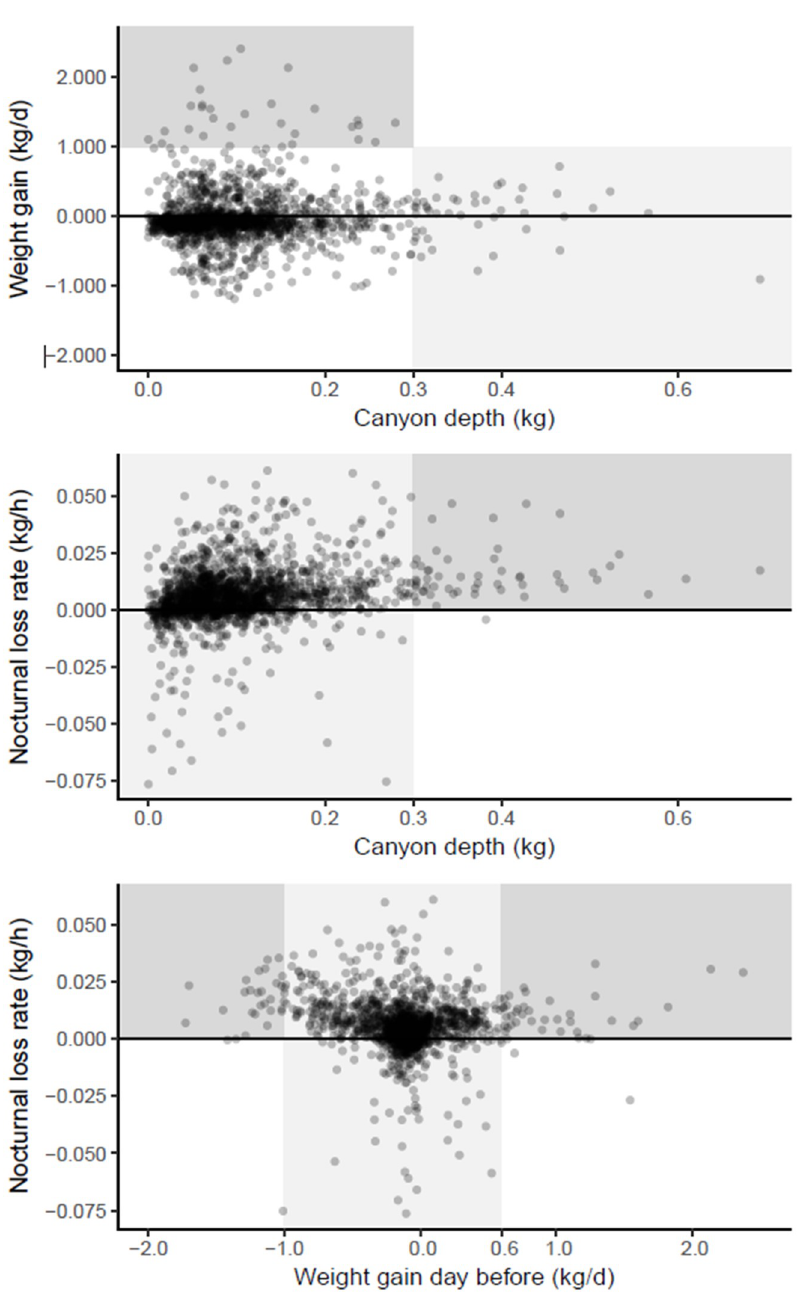
Figure 5. Scatter plots of parameter values estimated for each hive × date instance ( n = 3732). Weight gain is shown either for the same day ( top ) or for the day before ( bottom ). Light and dark shading shows patterns explained in text.